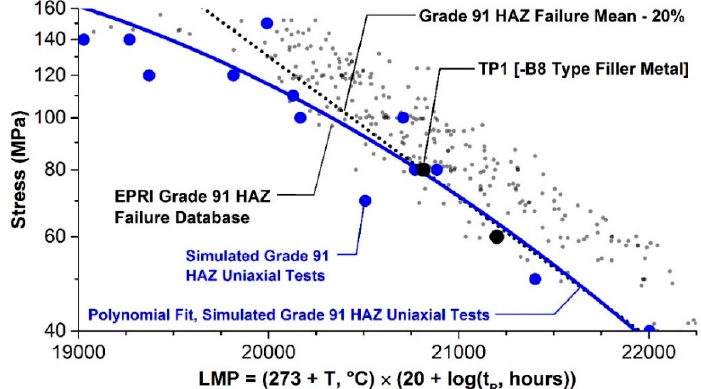
Figure 18. Relationship showing the creep performance of the HAZ defines the properties of cross weld specimens in long times.